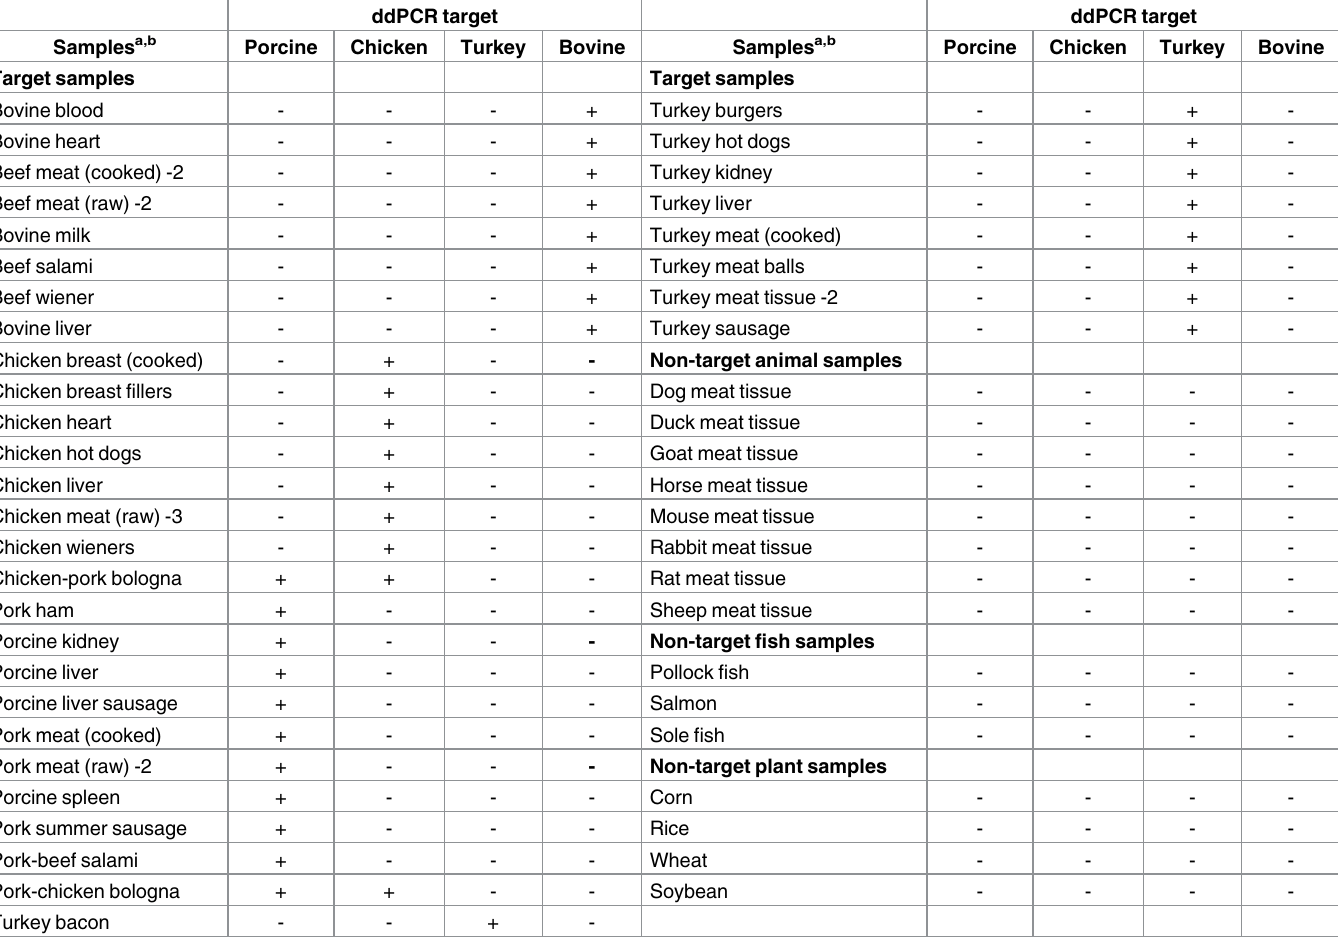
Table 2. Samples used and results for evaluating the specificity of ddPCR